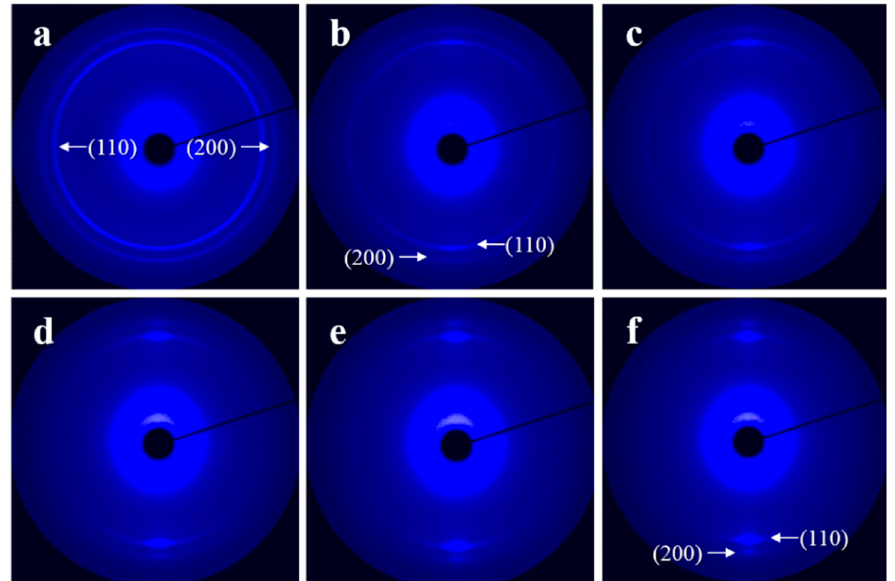
Figure 3. WAXD patterns of crystalline H-PCL/PVC (70/30) blend films drawn with a strain rate of 6 mm/min at room temperature to various draw ratios. ( a ) λ = 1, ( b ) λ = 2, ( c ) λ = 3, ( d ) λ = 4, ( e ) λ = 5, and ( f ) λ = 6. The draw direction is horizontal.